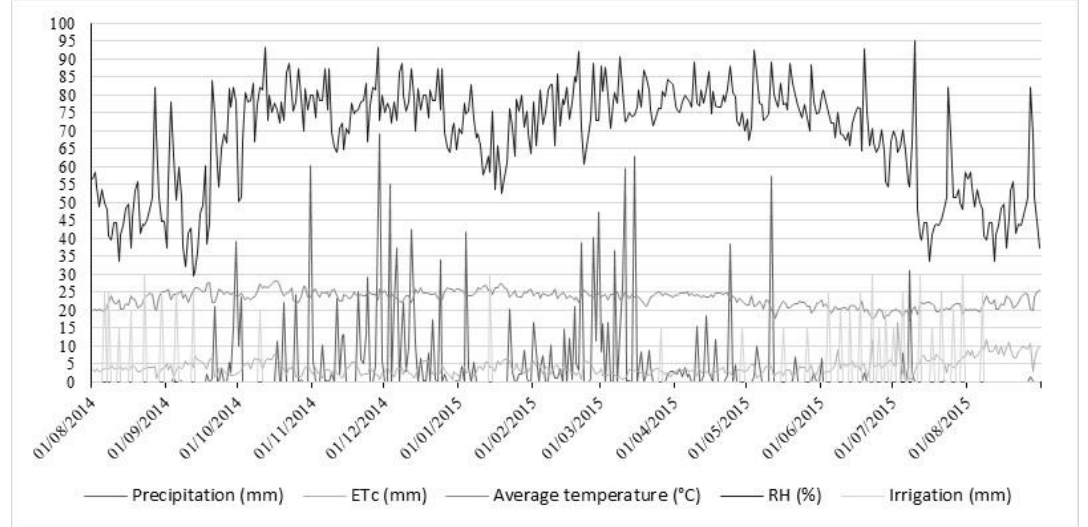
Figure 1. Daily water balance during the period of the experiment, Jataí—Goias harvest 2014/15. Source: INMET- National Institute of Meteorology Normal Station—Jataí—GO.